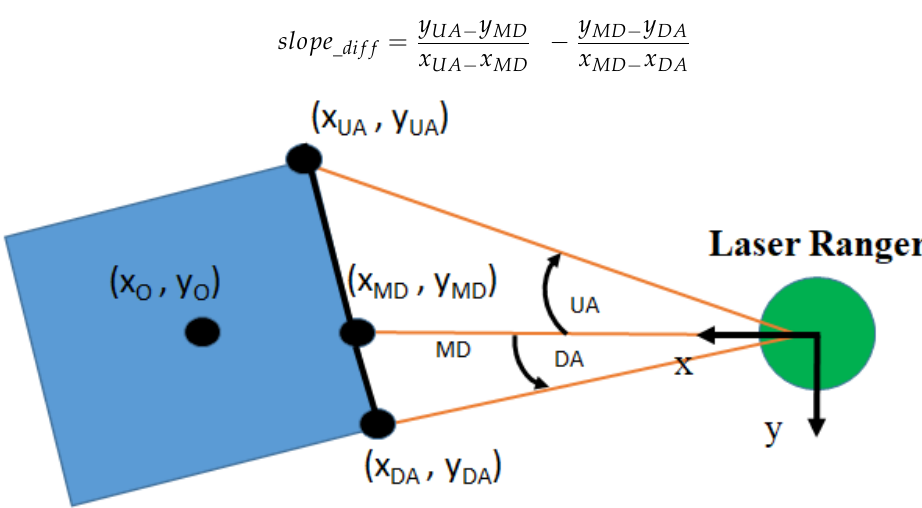
Figure 6. Square Figure 6. Square obstacle.